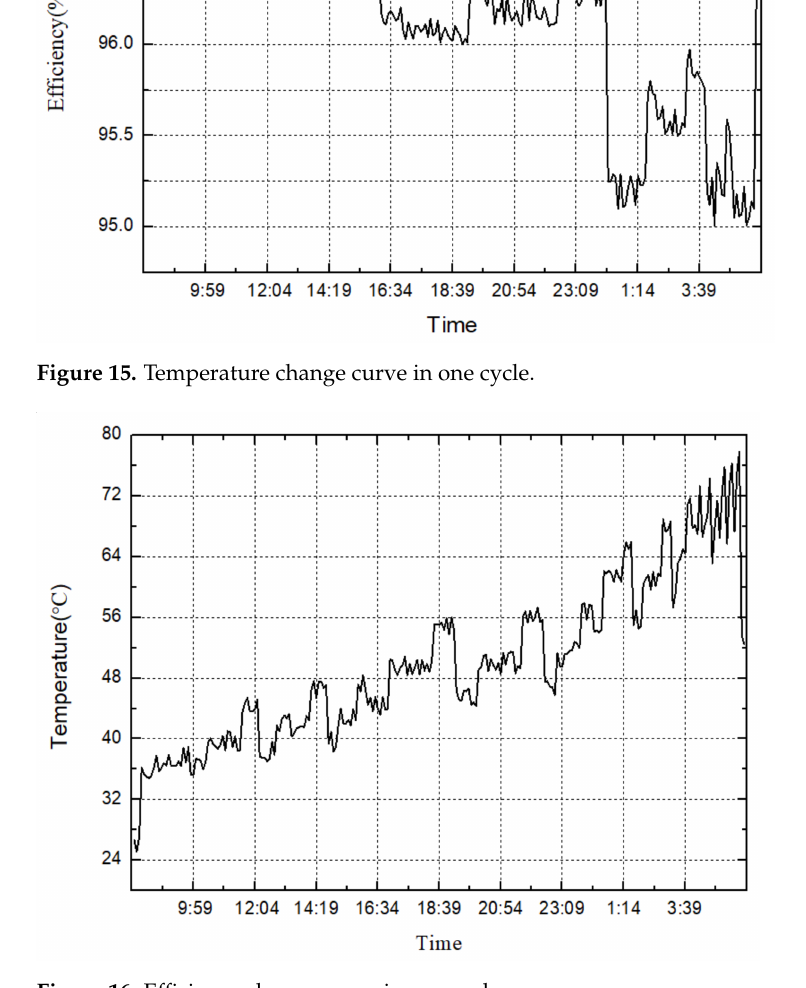
Figure 16. Efficiency change curve in one